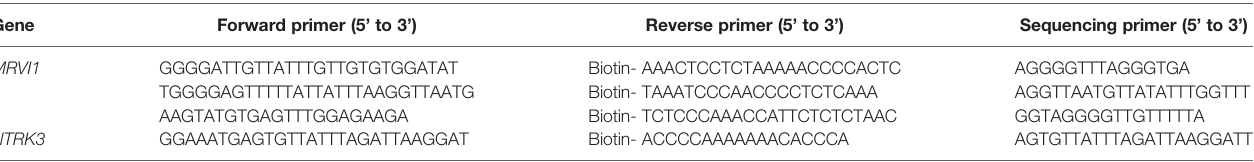
TABLE 3 | Primers used for the pyrosequencing